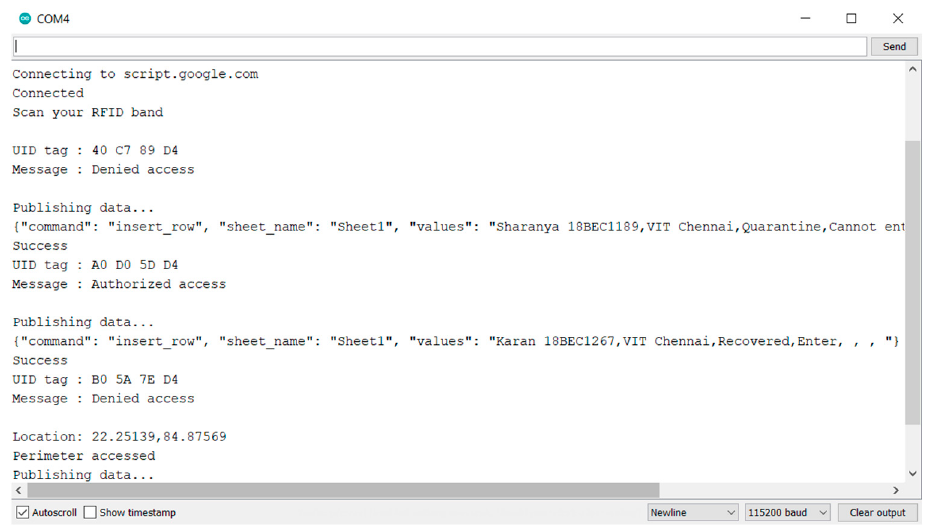
Figure A3. The COM window of Arduino IDE showing the scanning and publishing of user infor ‐ mation .